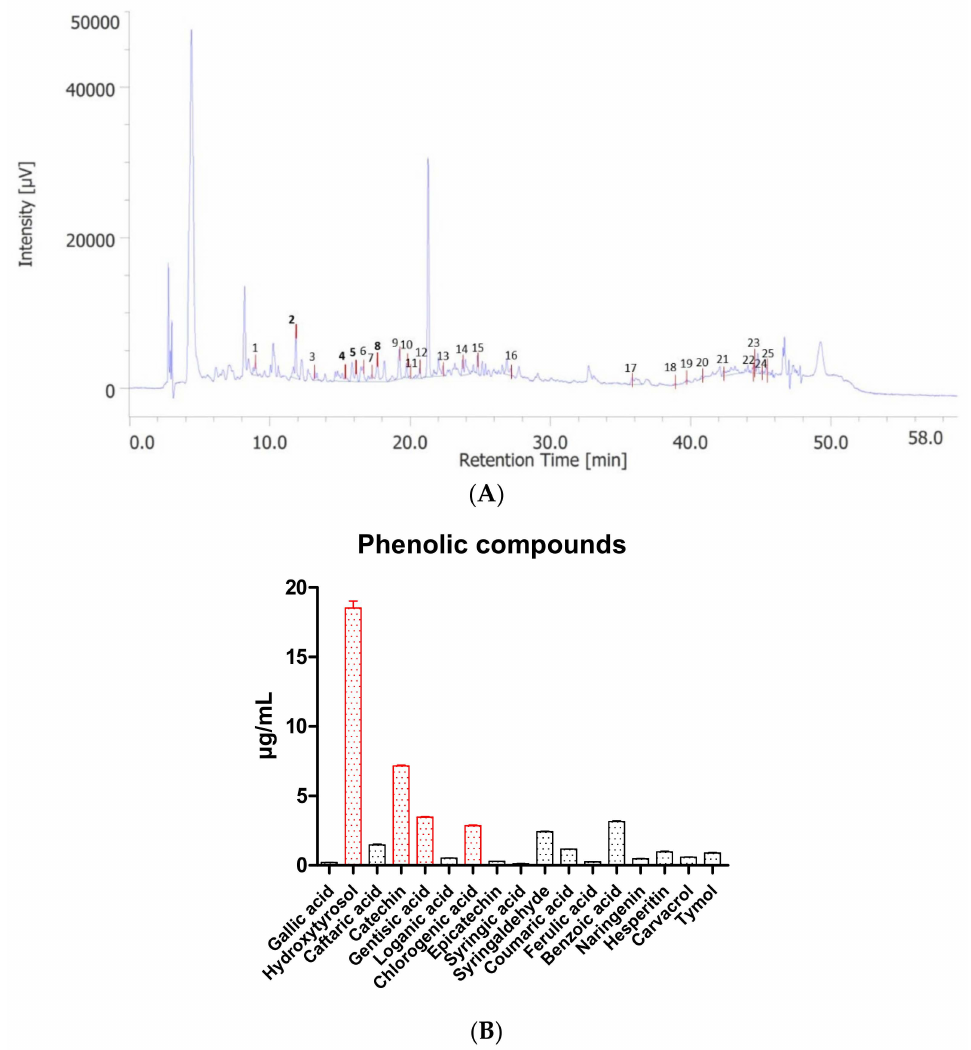
Figure 1. ( A ) Chromatogram related to the analysis of the hydroalcoholic extract from Graminex pollen. ( B ) Phenolic compounds identified and quantified in the extract. 3-Hydroxytyrosol (peak #2), catechin (peak #4), gentisic acid (peak #5), and chlorogenic acid (peak #8) were the most abundant phenolic compounds present in the